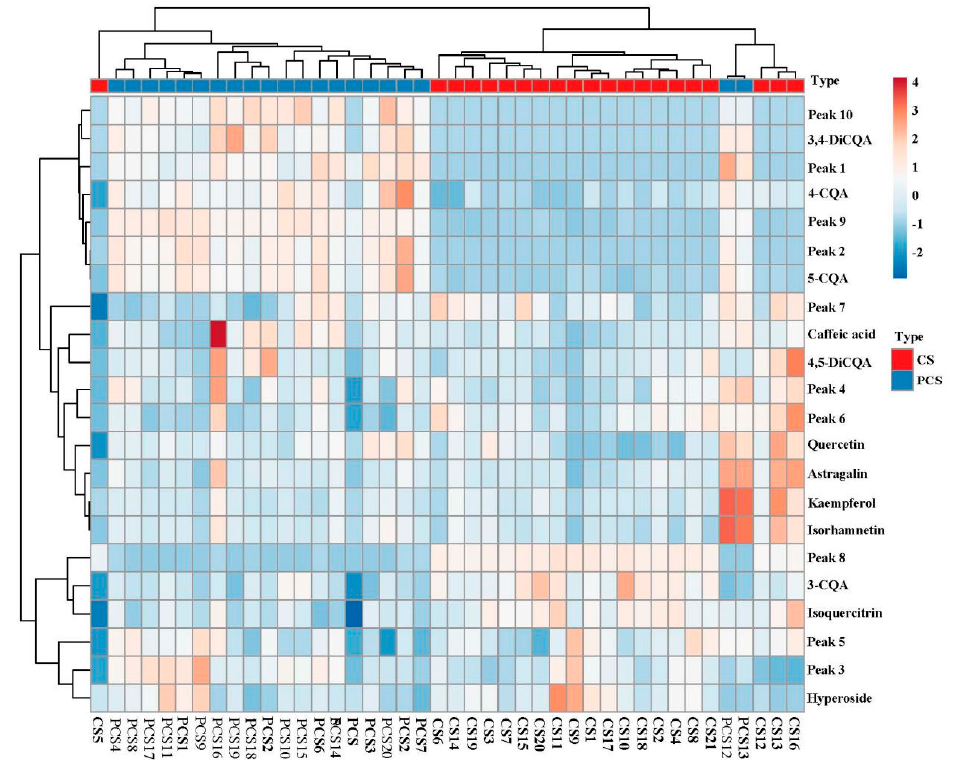
Figure 6. The HCA heatmap and clustering